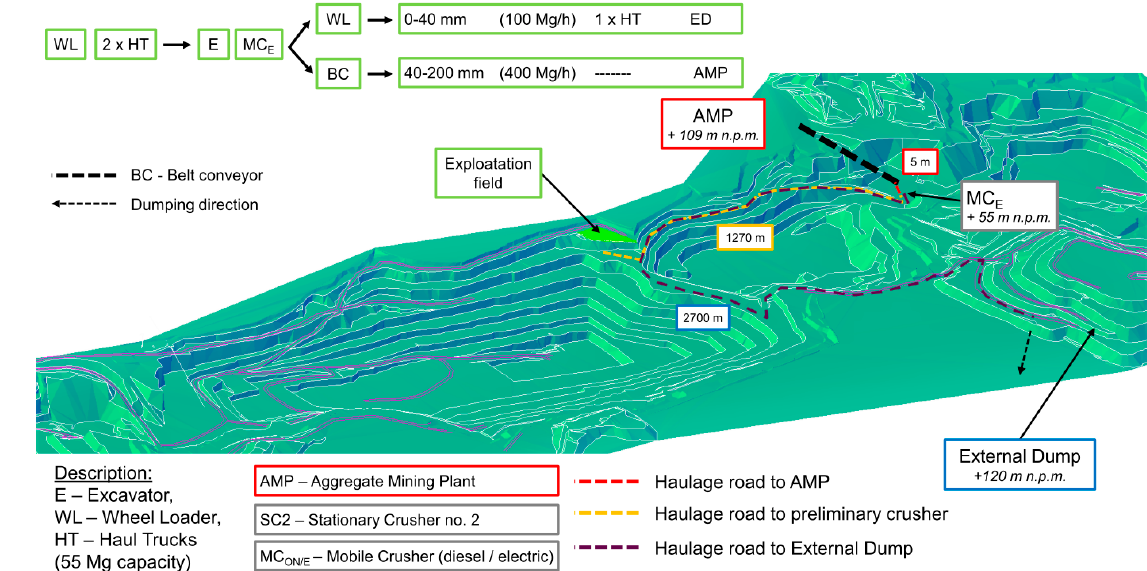
Figure 3. Primary crusher locations in the analyzed mine—Decision Variants no. 2.